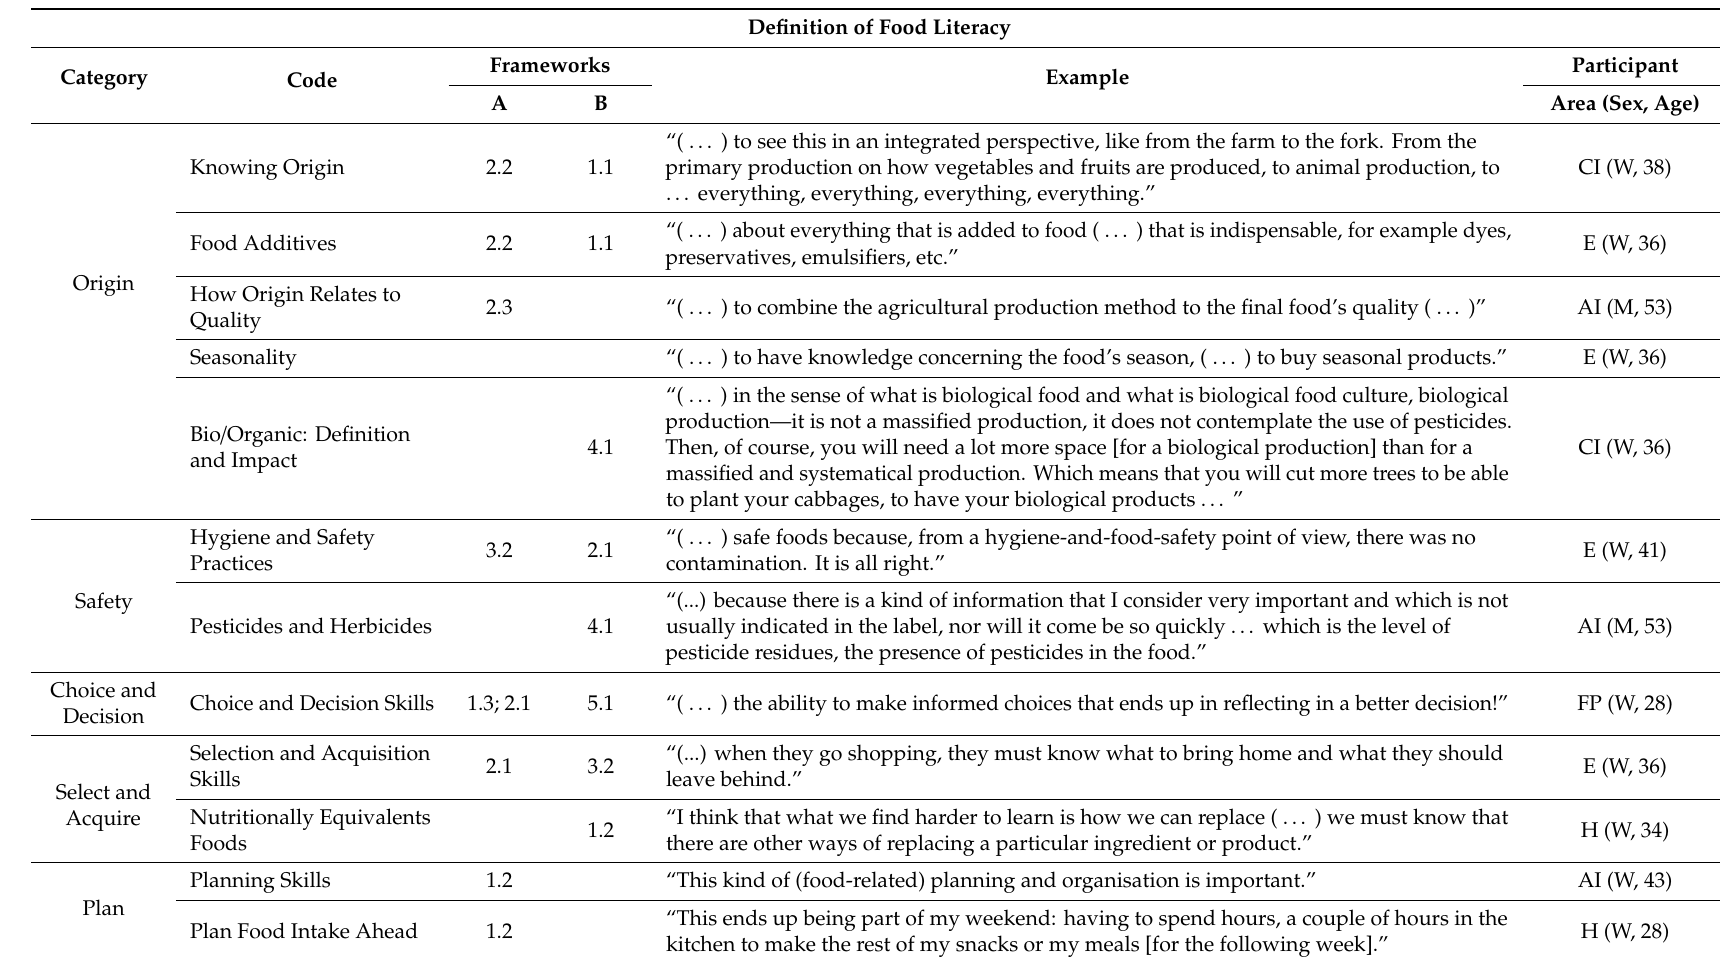
Table 2. Representation of the theme “Definition of Food Literacy”, its domains (categories) and respective attributes (codes), the coding against conceptual frameworks [3,13], an exemplifying quote and its respective author’s professional and demographic